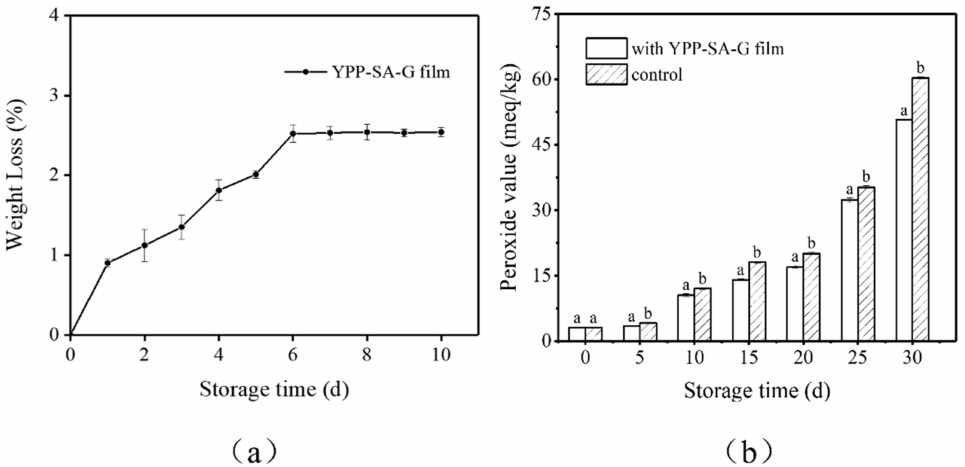
Figure 8. ( a ) Weight loss of oil bags made from YPP-SA-G film for 10 days storage; ( b ) The changes in peroxide value of soybean oil during 30 days